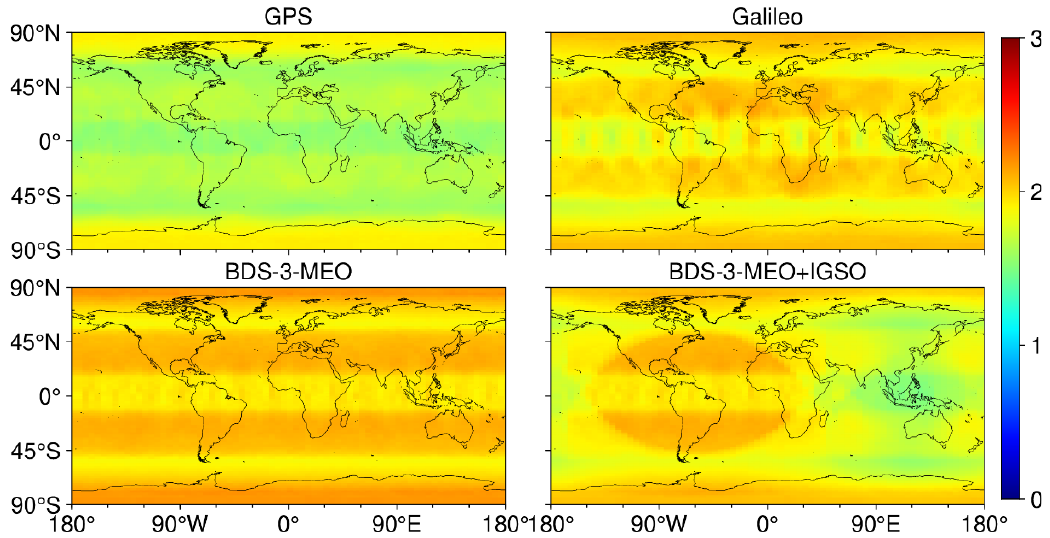
Figure 3. Average PDOP value of GPS, Galileo, BDS-3 MEO, and BDS-3 MEO+IGSO over a day (1 September 2022) with an elevation cut-off of 7°.